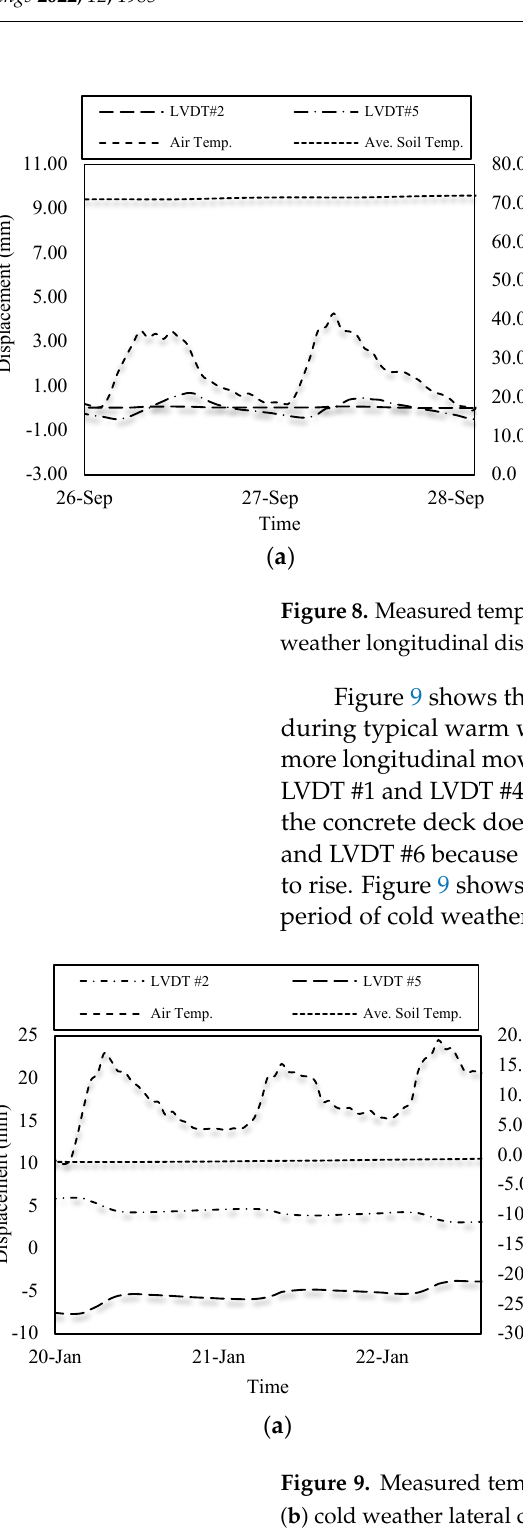
Figure 10. Average LVDT Displacement vs. Temperature.